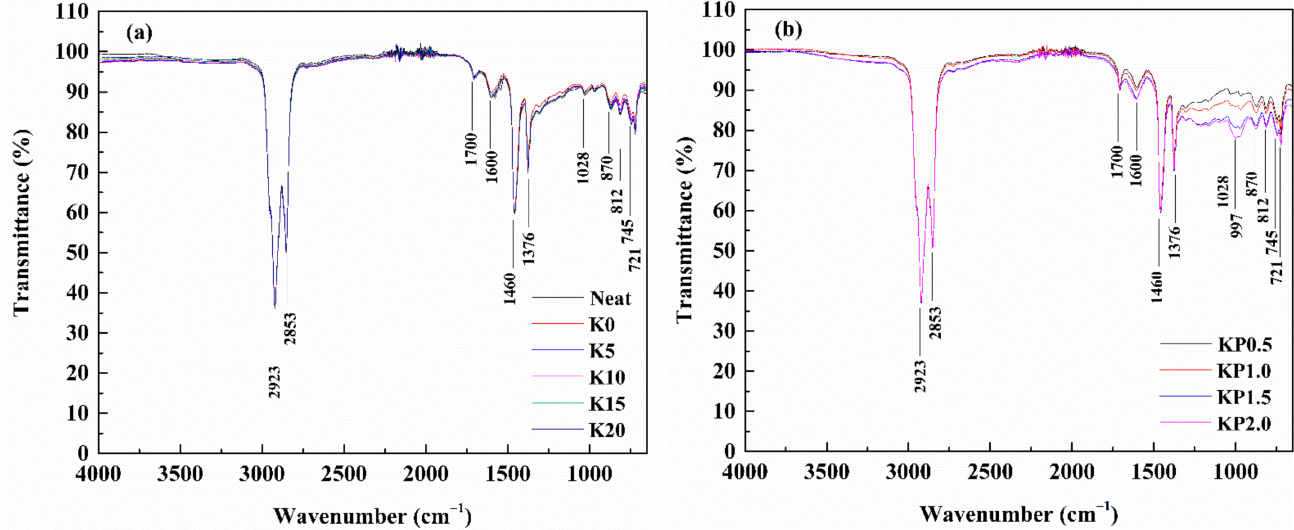
Figure 14. FTIR spectra of tested samples: ( a ) SBS/OSDOA-modified asphalts; ( b ) composite modified